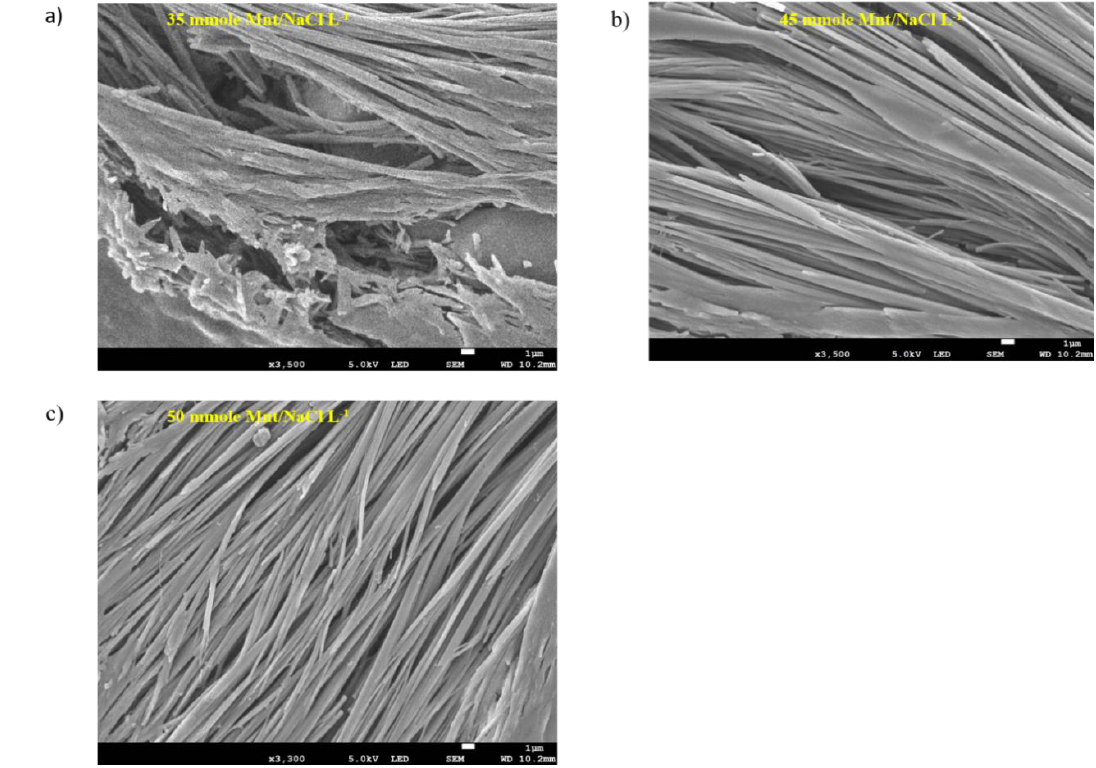
Figure 6. FESEM images of gels composed of 60 mmole L −1 Na-DOC and 35, 45, and 50 mmole L −1 Mnt/NaCl (1:1 mmole L −1 concentration ratio of Mnt/NaCl used). Mnt / NaCl (1:1 mmole L − 1 concentration ratio of Mnt / NaCl